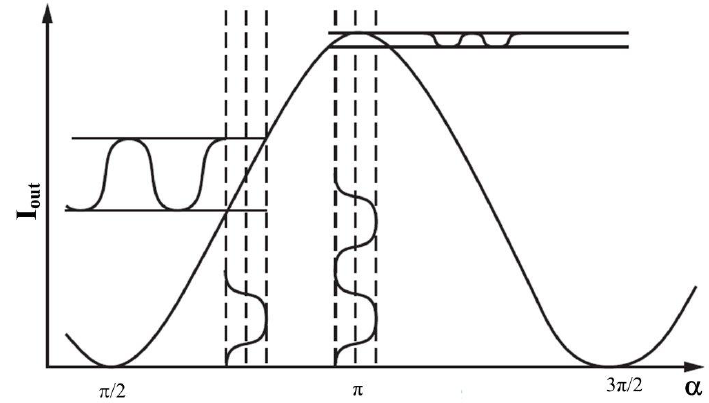
Figure 3. Transfer function of two polarizers showing the transmitted power as a function of their relative angle.